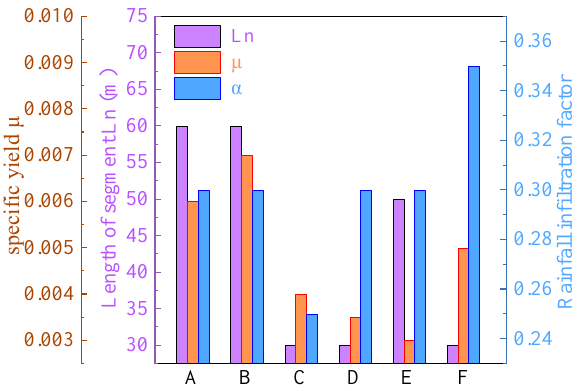
Figure 11. Parameters of each segment.